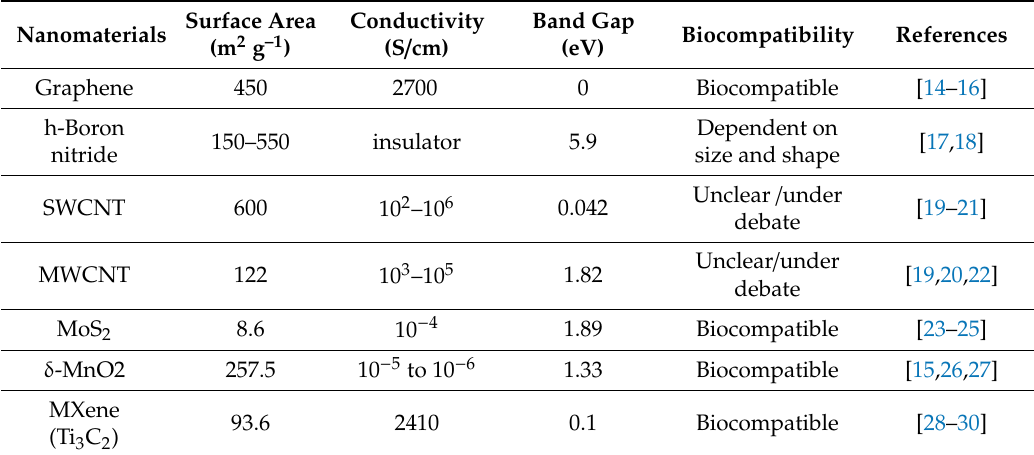
Table 1. Comparison of fundamental properties of various